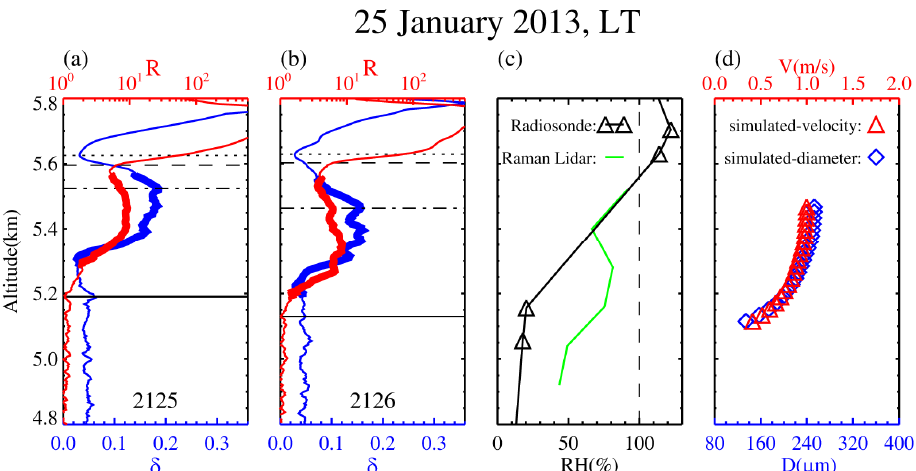
Figure 4. Two sequential 1-min profiles of backscatter ratio (red) and depolarization ratio (blue) obtained by the polarization lidar at ( a ) 2125 and ( b ) 2126 LT on 25 January 2013, ( c ) Profiles of relative humidity over ice from local radiosonde (black with triangle) at 2000 LT and our Raman lidar (green) around 2125 LT, and ( d ) altitude variations of ice particle diameter (blue diamond) and corresponding terminal velocity (red triangle) calculated with a conventional ice particle sublimation model mentioned in Section 2.3. The parent cloud base height (R ~ 7.0) and δ -minimum height are indicated by dash and dotted lines, respectively. The depolarization ratio had values larger than 0.15 at altitudes of 5.3-5.5 km, showing the presence of ice crystals. Note that the ice virga layer ( ∼ 5.25-5.55 km) showed coherent structure (bold line) and altitude shift as seen from the two sequential 1-min δ profiles. This allowed us to estimate the falling speed of bulk ice crystals.